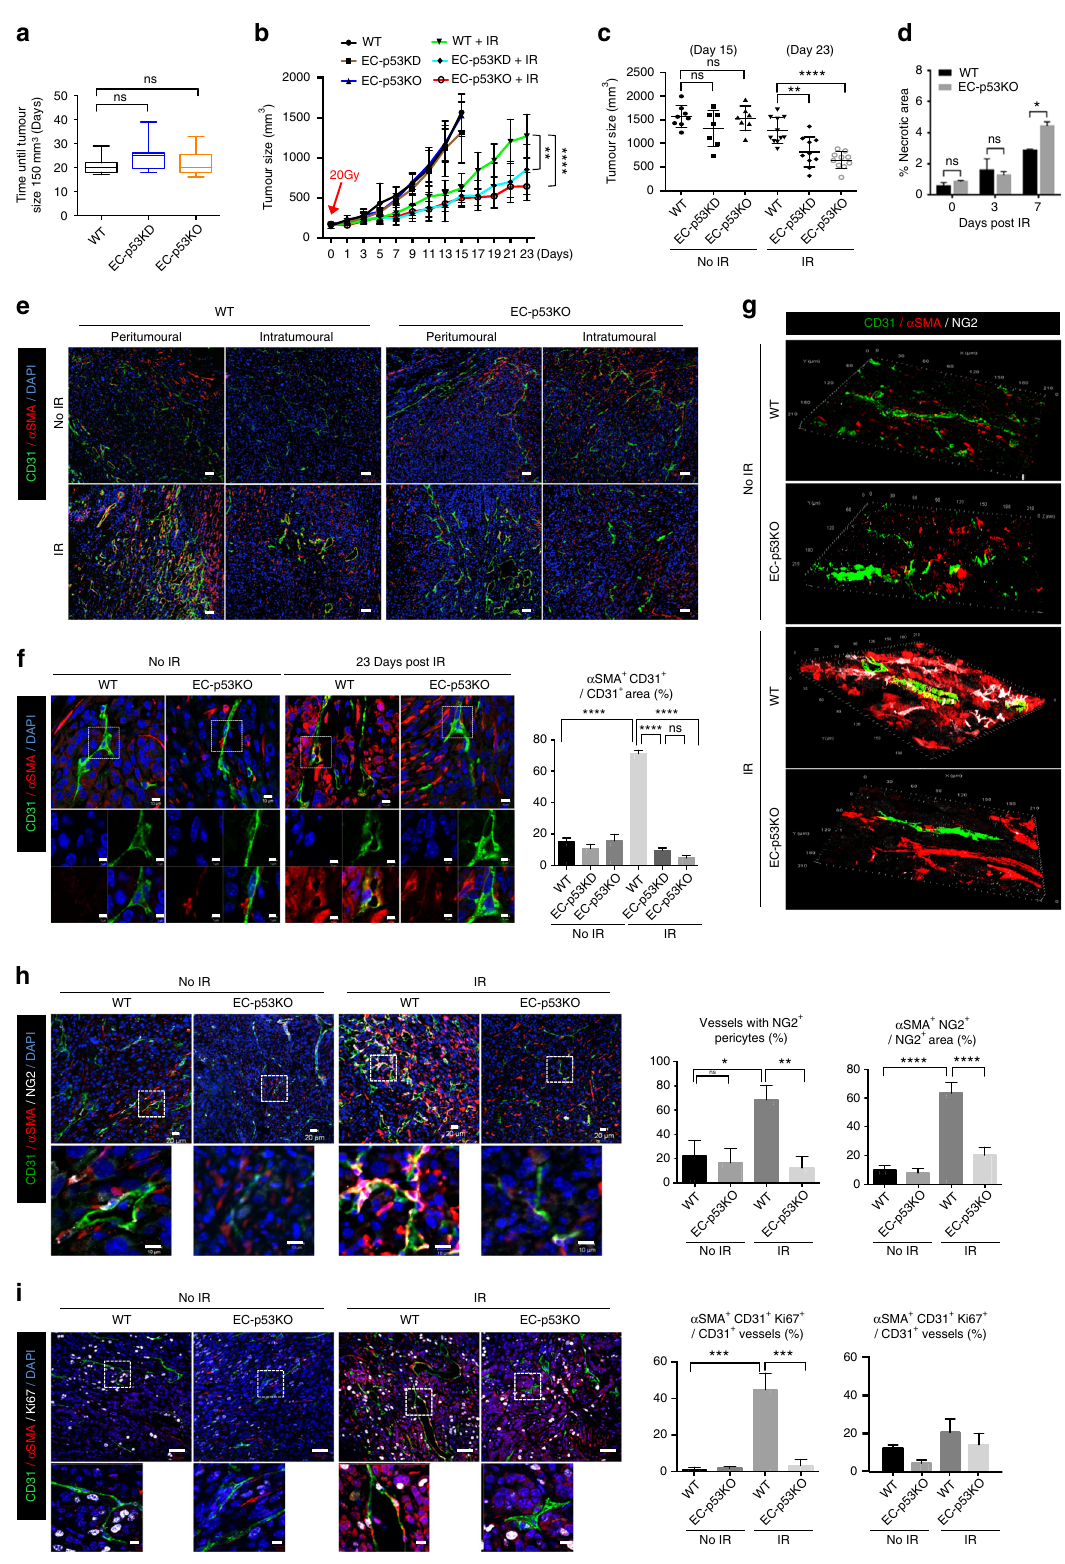
Fig. 4b). We analysed the EndMT and pericyte population in greater detail by endothelial lineage tracking using cells expres- sing tdTomato-labelled Cre. To this end, we generated EC- tdTomato and EC-tdTomato;p53KO mice (Tie2-Cre;tdTomato and Tie2-Cre;tdTomato Trp53 fl ox/ fl ox , respectively) NATURE COMMUNICATIONS| (2018) 9:5108 |DOI: